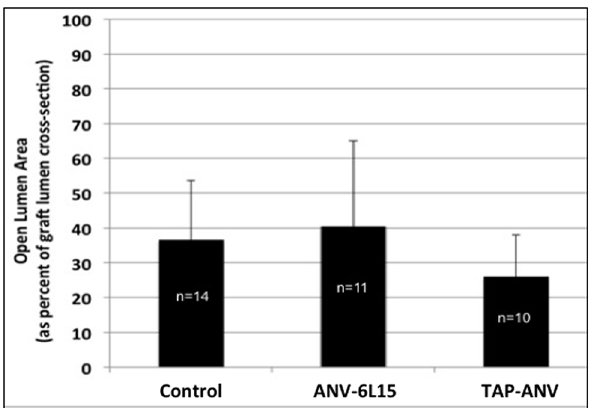
Fig 6. Effect of anti-thrombotic fusion protein treatment on open lumen area determined by MR imaging. Control = heparin-treated. A value of 100 would indicate the graft lumen was completely open in the vein-graft anastomosis cross-section; a value of 0 would indicate the lumen of the graft was completely occluded. There was no significant difference in the open lumen area amongst treatment groups. The bars represent means ±